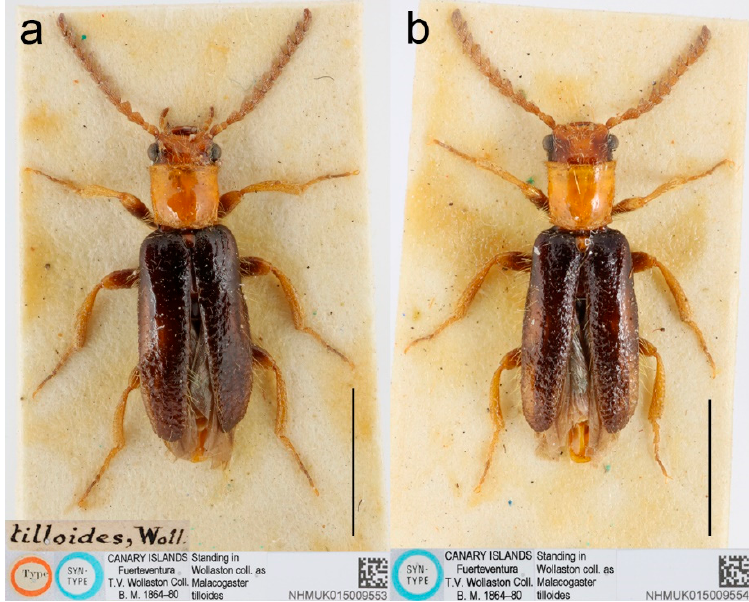
Figure 23. Malacogaster tilloides Wollaston, 1864, male syntypes (BMNH). ( a , b ) Habitus, dorsal view. Scale bars = ( a ) 3.0 mm; ( b ) 2.5 mm. Photographs courtesy of K. Matsumoto (BMNH).